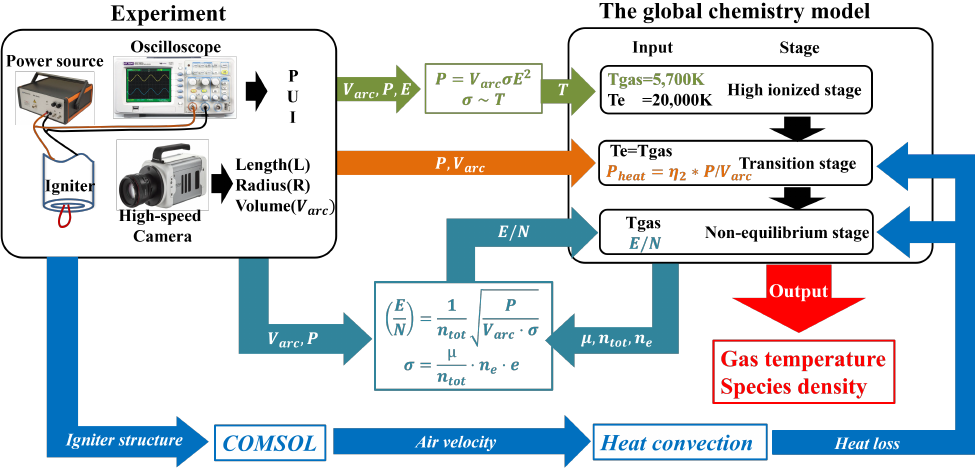
Figure 4. Combined schematic of the experimental system and the global chemistry